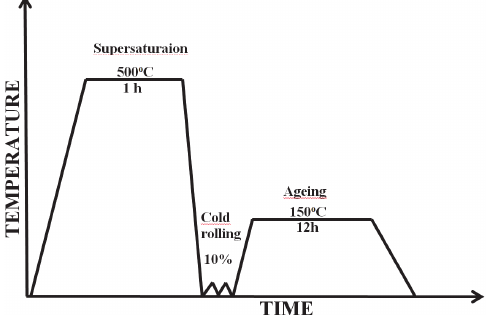
Figure 1: Scheme of low-temperature thermomechanical treatment of AlZn6Mg0.8Zr alloy.